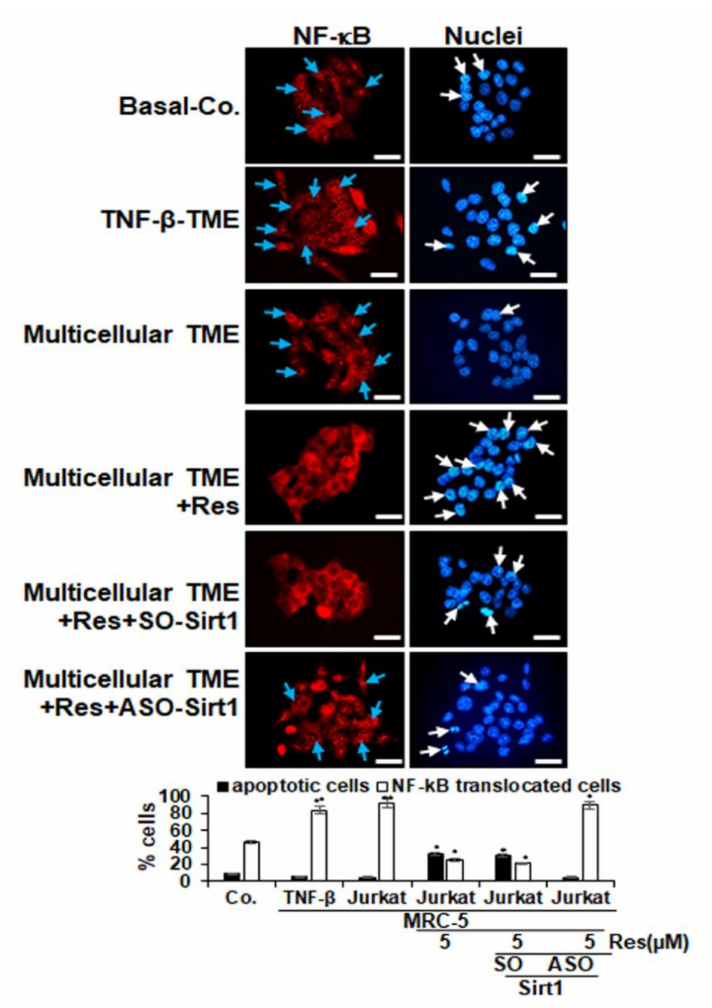
Figure 4. Impact of resveratrol and Sirt1-ASO on activation and nuclear translocation of p65-NF- κ B in CRC cells in the multicellular-TME. Serum-starved HCT116 cells in monolayer cultures alone (basal control = co) or co-cultured with fibroblasts and TNF- β (10 ng / mL) (TNF- β -TME) or co-cultured with fibroblasts and T-lymphocytes (pro-inflammatory multicellular-TME) were either left untreated, or multicellular-TME cultures were treated with resveratrol (5 µ M) for 4h in monolayer cultures, or transfected with 0.5 µ M sense oligonucleotide (SO) control, or antisense oligonucleotides (ASO) against Sirt1 in the presence of Lipofectin transfection reagent (10 µ L / mL) and co-treated with resveratrol (5 µ M) for 4 h in monolayer cultures, as described in the Materials and Methods section. Magnification 600 × ; scale bar = 30 mm. All experiments were performed at least in triplicate and quantification of positively labelled p65-NF- κ B-nuclei (blue arrows) and apoptotic nuclei (white arrows) were performed by counting 500–600 cells from 25 di ff erent microscopic fields (C). * p < 0.05, ** p < 0.01 relative to basal